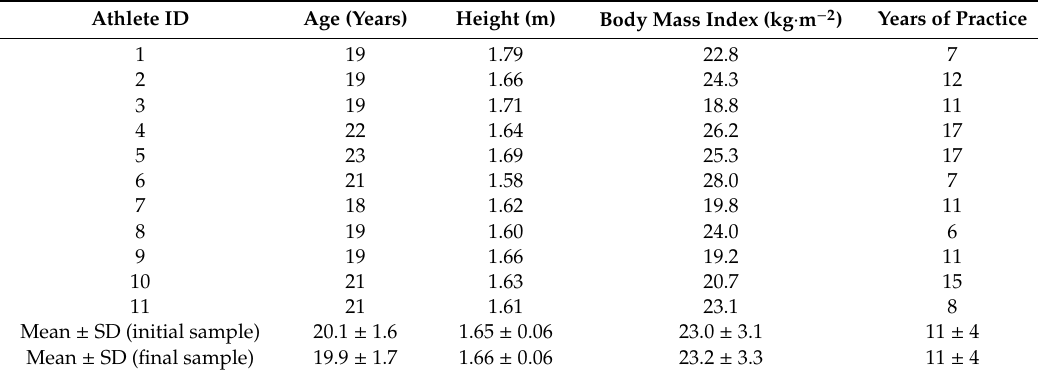
Table 1. Volunteers’ relevant characteristics.